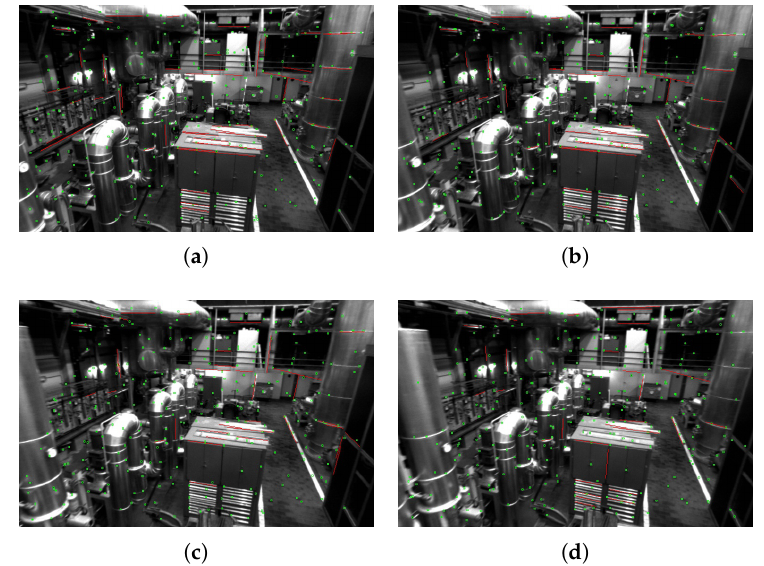
Figure 7. The MH _02_ easy sequence tracks the point and line features of successive frames. The points are indicated in green and the segments are indicated in red. Figure ( a – d ) are consecutive images on the MH _02_ easy sequence, drawed with point and line features which can be successfully